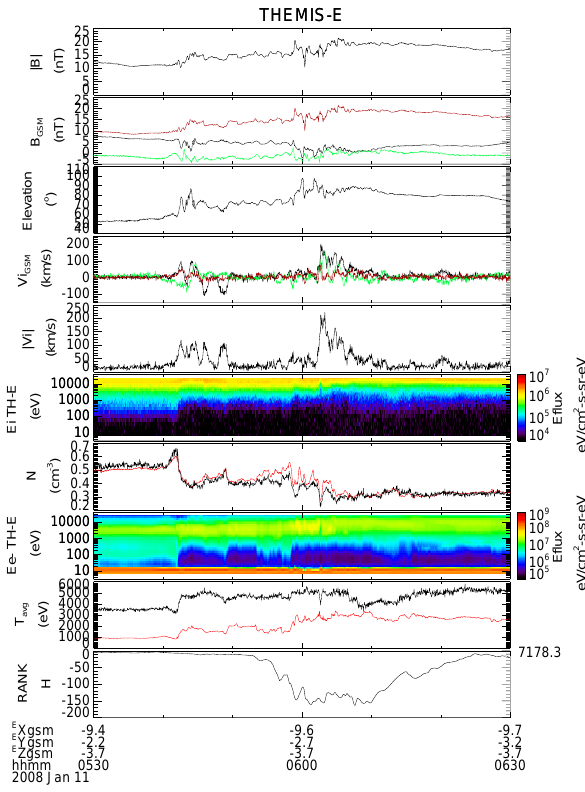
Fig. 2. Themis E observations on 11 January 2008, between 05:30– 06:30UT of, from top to bottom, the total magnetic field, the three GSM components of the magnetic field, the magnetic field eleva- tion angle (where 0 ◦ corresponds to Earthward direction, 180 ◦ to tailward direction and 90 ◦ is along the GSM z-axis), the three GSM components of the ion flow velocity, the total velocity of the ion flow, ion energy-time spectrogram, ion and electron (red) densities, electron energy-time spectrogram, ion and electron (red) tempera- tures. The black, green and red lines in panels two and four are the x, y and z components of the magnetic field and the ion flow. In the last panel, the deviation in the H component of the magnetic field observed at Rankin Inlet, is displayed.